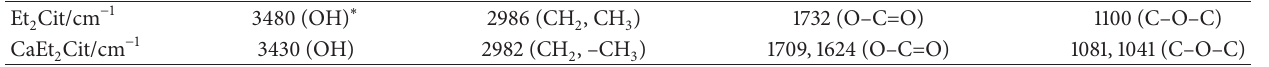
Cit and its complex CaEt 2